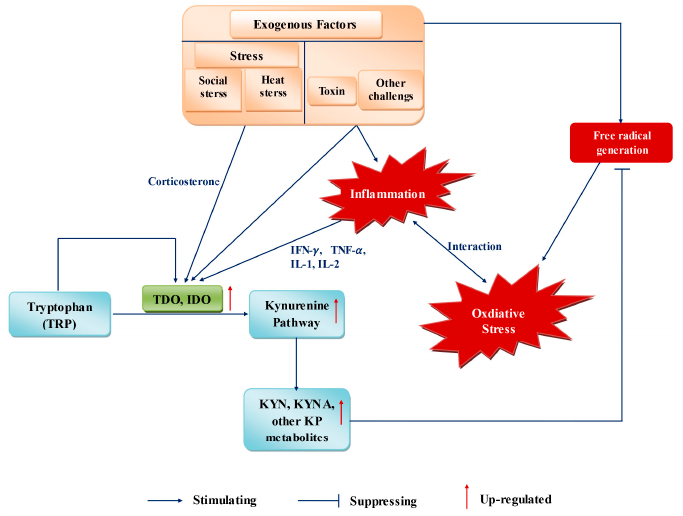
Figure 2. Kynurenine pathway acts as a regulator of antioxidant responses and support complementary antioxidant capabilities when bodies influenced by some exogenous factors. TDO, tryptophan 2,3-dioxygenase; IDO, indoleamine 2,3-dioxygenase; IFN- γ , interferon- γ ; IFN- α , interferon- α ; IL-1, interleukin-1 family; IL-2, interleukin-2; KYN, kynurenine; KYNA, kynurenic acid; KP, kynurenine pathway.